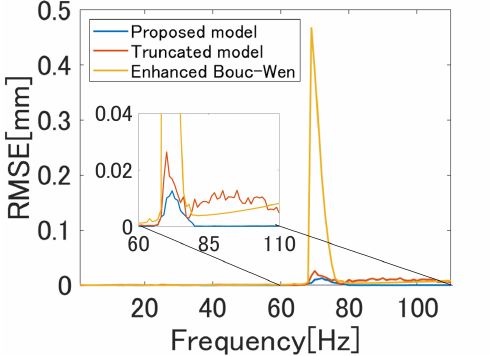
Figure 13. RMSE metrics of the three models tested.